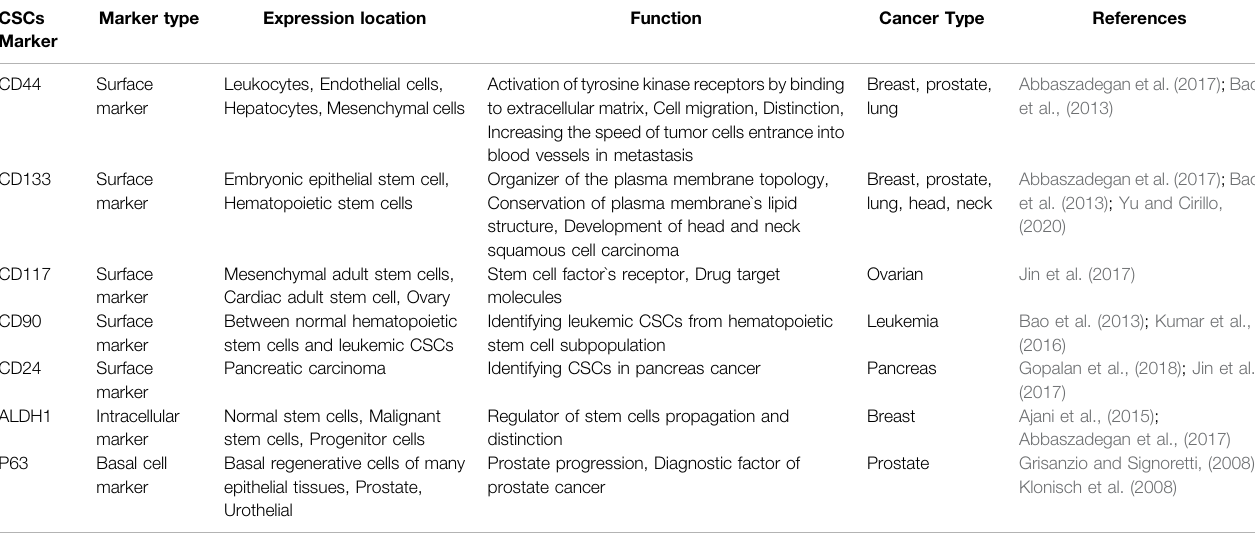
TABLE 1 | Most frequently applied markers for cancer stem cells